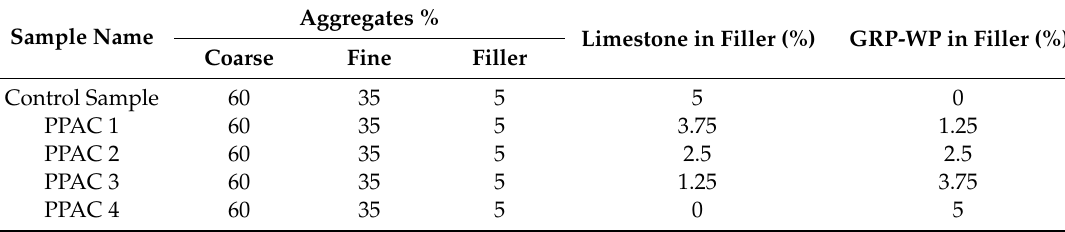
Table 4. Experimental test matrix used in this study.